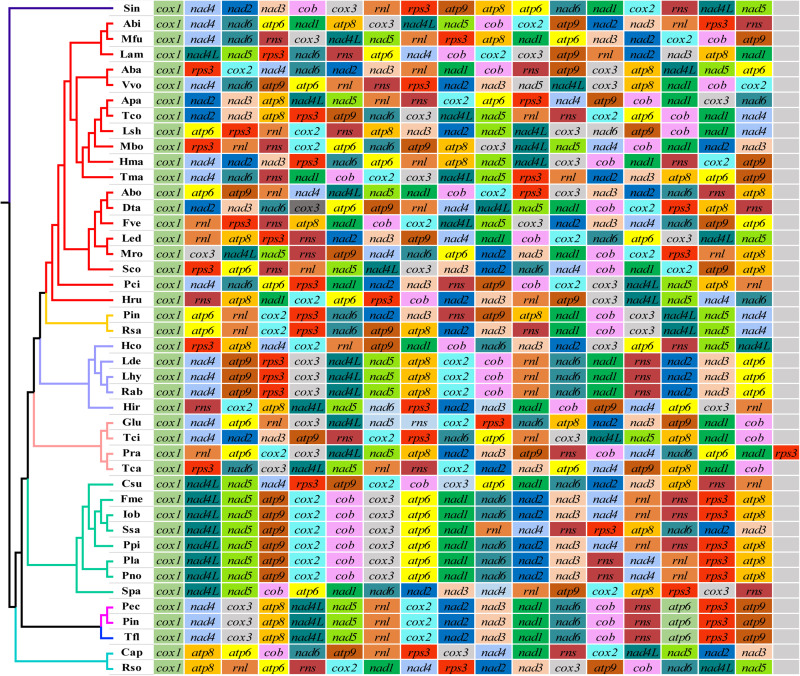
Mitochondrial gene arrangement analyses of 44 Basidiomycete species. Genes are represented with different color blocks. All genes are shown in order of occurrence in the mitochondrial genome, starting from cox1. Fourteen core protein-coding genes, one rps3 gene, and two rRNA genes were included in the gene arrangement analysis. Species and NCBI accession number used for gene arrangement analysis in the present study are listed in Supplementary Table S5.